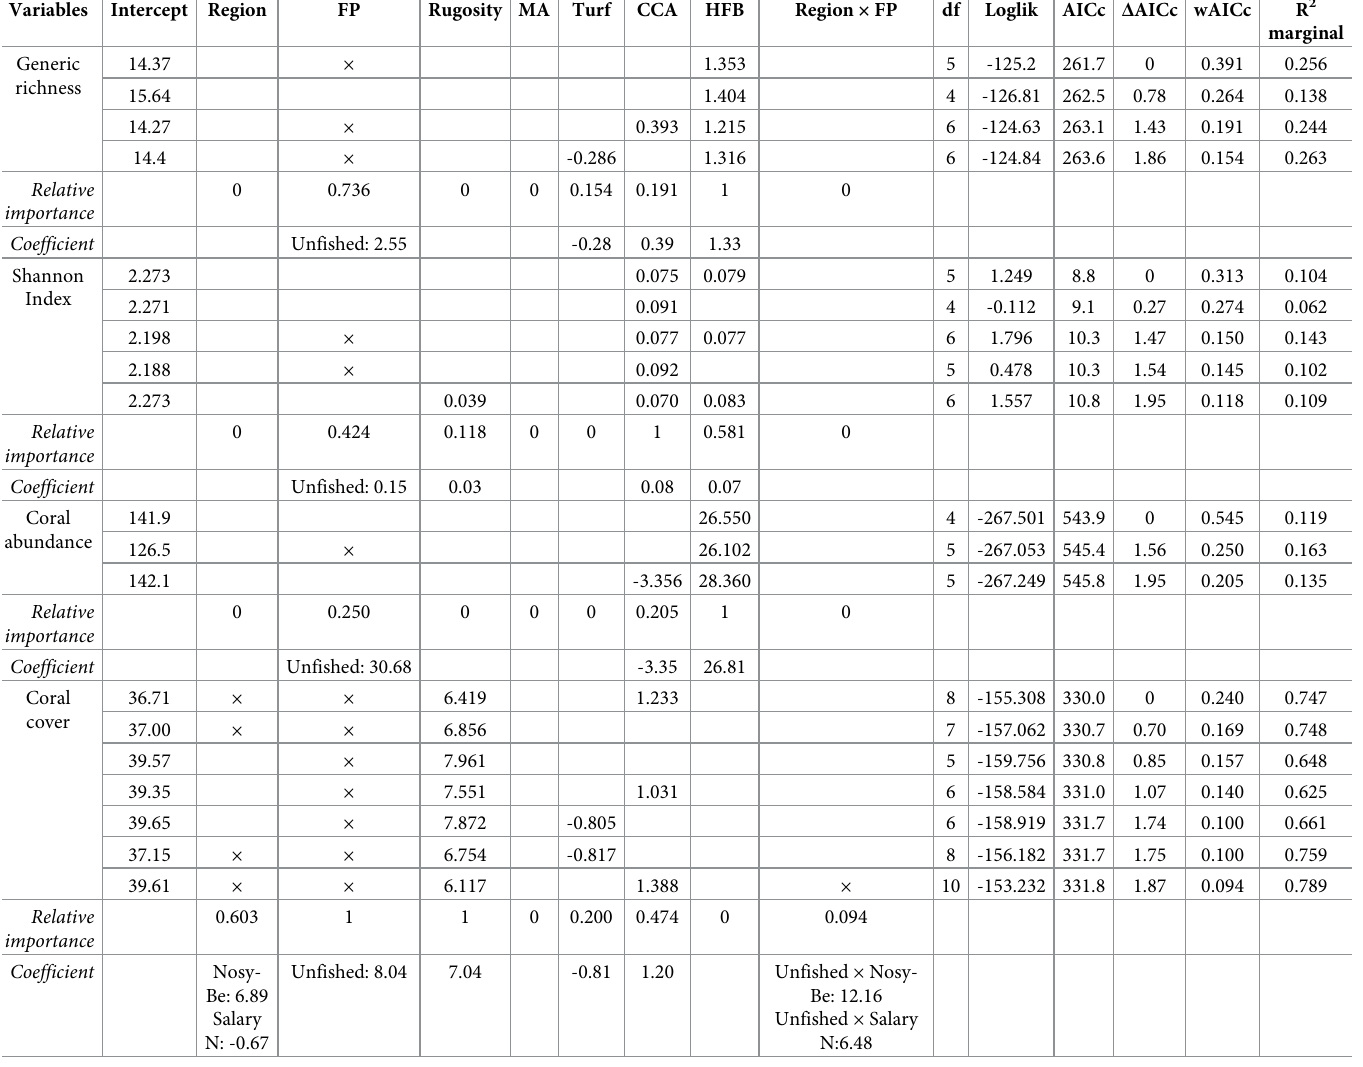
Table 2. Summary of best linear mixed models using a Gaussian distribution to describe variation of generic richness, Shannon diversity index, coral abundance, and coral cover. FP: fishing protection level, MA: macroalgae, CCA: crustose coralline algae, HFB: herbivorous fish